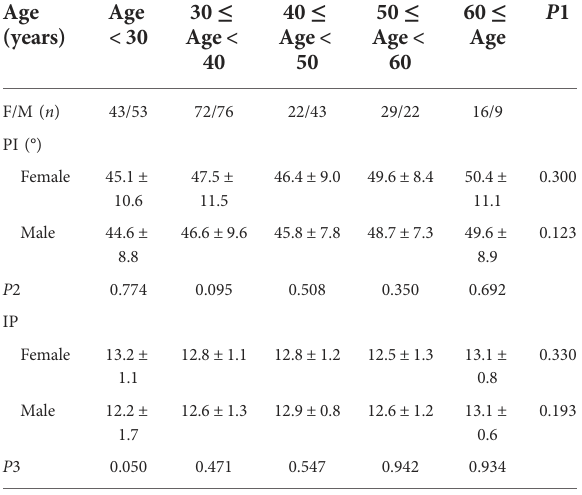
TABLE 2 The age strati fi ed PI and IP in asymptomatic Chinese adults with different gender groups.